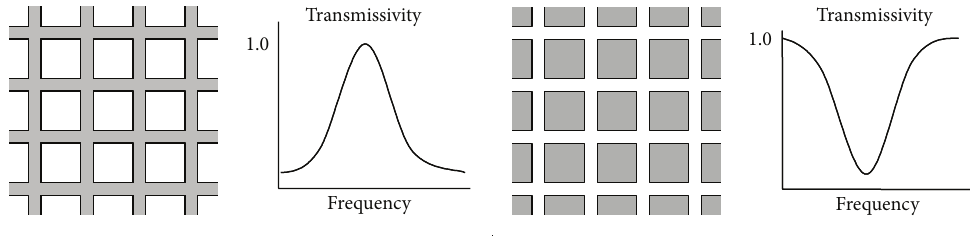
Figure 1: Inductive and capacitive screen.